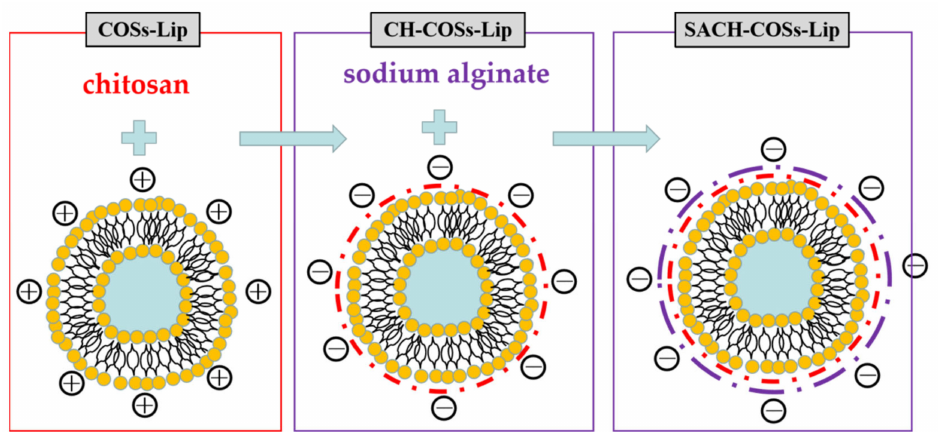
Figure 2. Chemical interaction during the preparation of chito-oligosaccharides nano-liposomes by layer-by-layer coated with chitosan and sodium